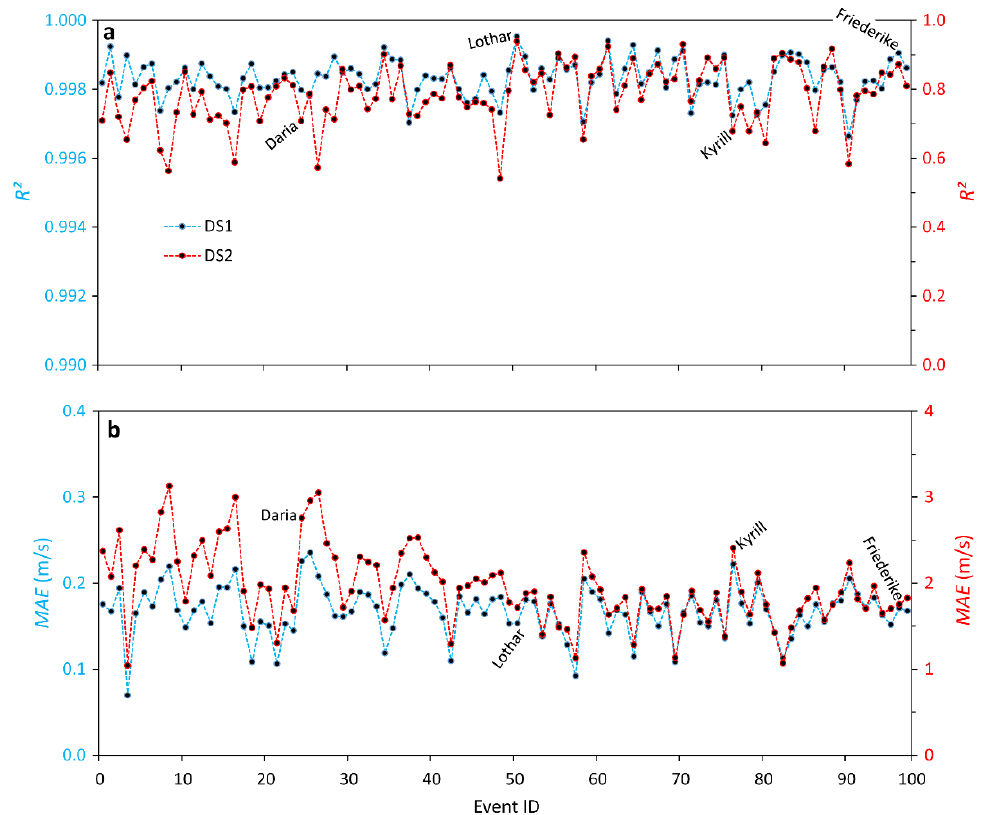
Figure 9. Storm event-related ( a ) coefficient of determination ( R 2 ) and ( b ) mean absolute error ( MAE ) of the parameterization dataset (DS1) and the test dataset (DS2). Please note the different scaling of the y-axes.